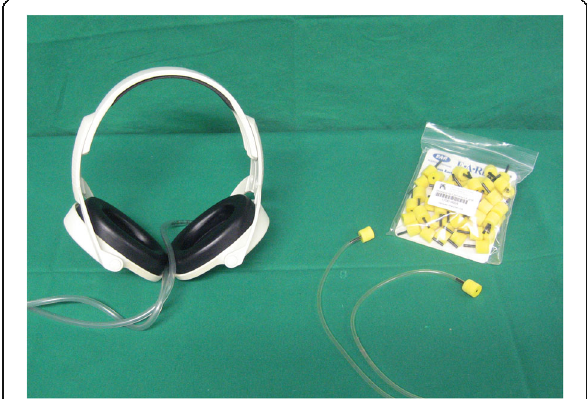
Fig. 1 Left: standard pneumatic headphone (Siemens), right: earphones (3M) connected to the pneumatic audio system of the